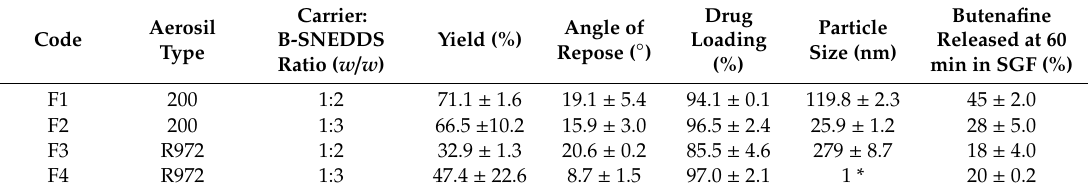
Table 3. Characterisation of the solid B-SNEDDS. Results are reported as mean ± SD ( n =